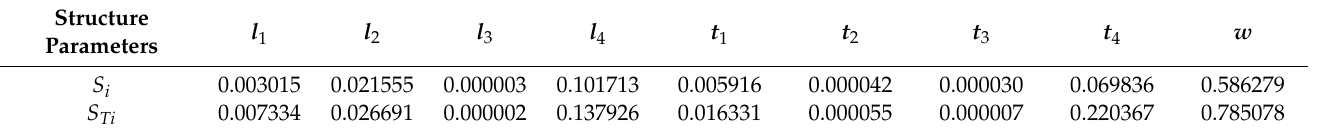
Table 4. The sensitivity of structure parameters to